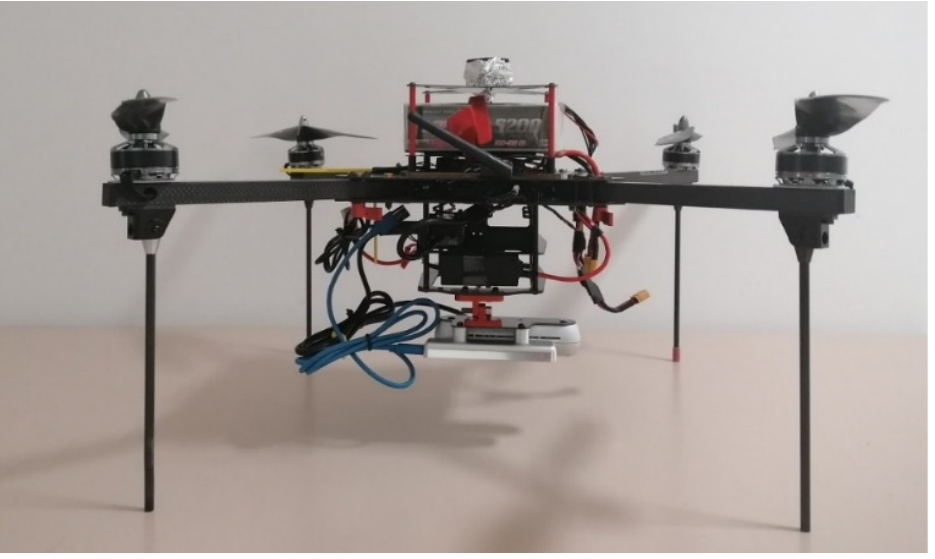
Figure 1. The exploited aerial